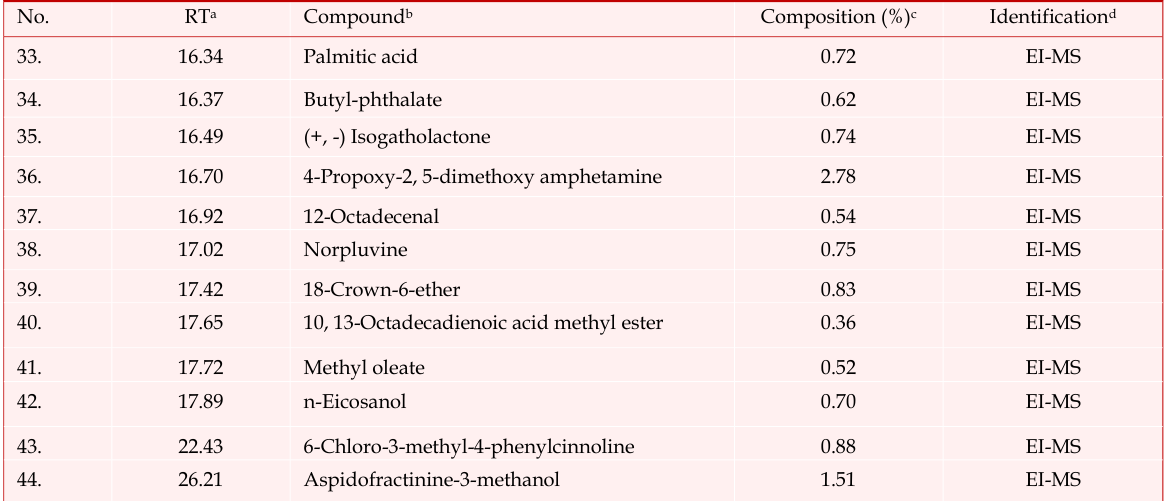
GC-MS chemical composition of essential oil isolated from the floral parts of L. lucidum (Cont.)